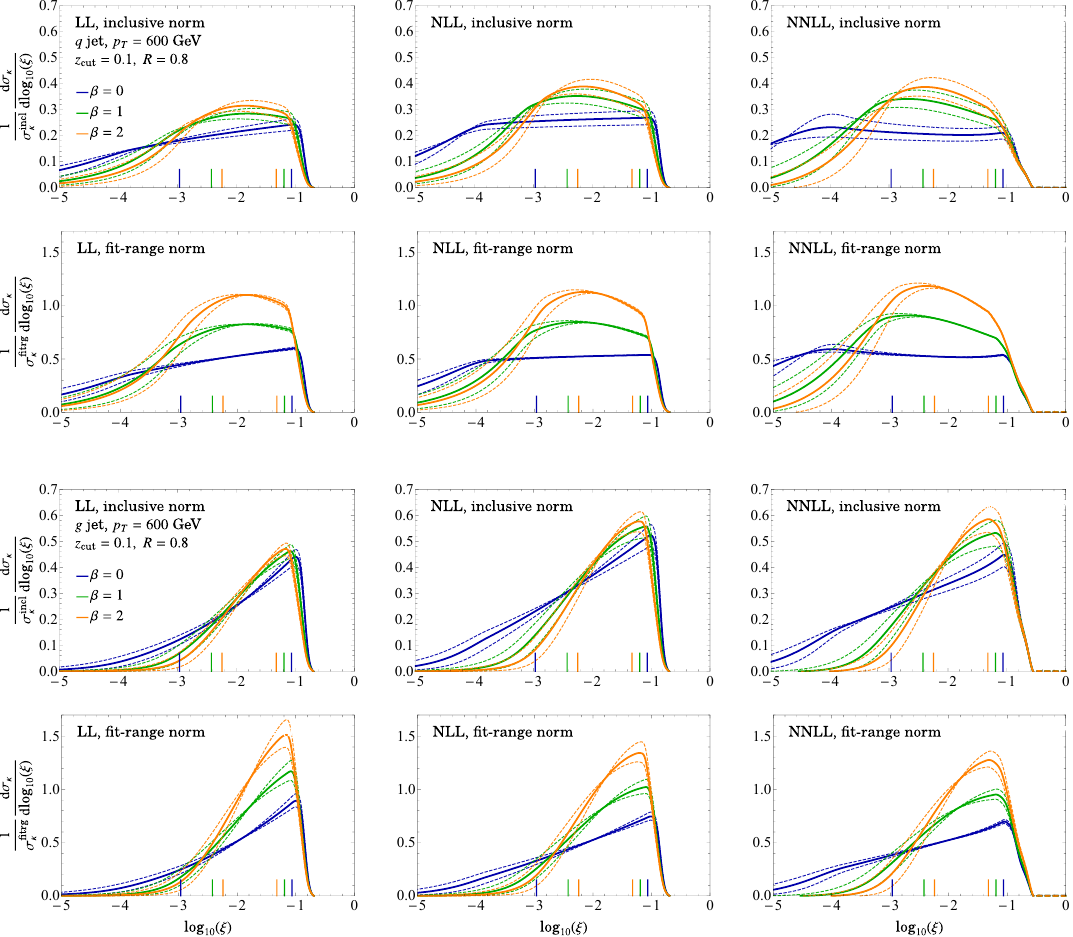
Figure 7 . The α s dependence of the normalized jet-mass spectrum of quark jets (top two rows) and gluon jets (bottom two rows), for various logarithmic orders (columns) and with different normalizations (rows 1 and 3 use the inclusive cross section normalization, while rows 2 and 4 are normalized in the fit range). Solid curves show matched jet-mass spectrum for α while dashed curves correspond those with a ± 10 % variation in α of the fit range in which the curves are normalized is indicated with vertical lines, for each value of β